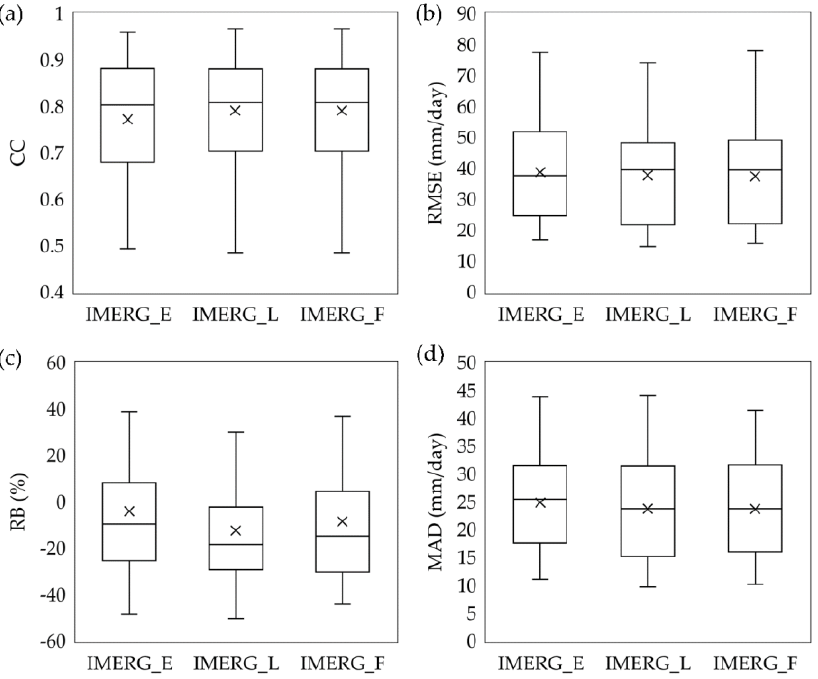
Figure 8. Box plots of ( a ) CC; ( b ) RMSE; ( c ) RB and ( d ) MAD statistical metrics of the GPM IMERG products against gauge during the 2014–2015 flood period.